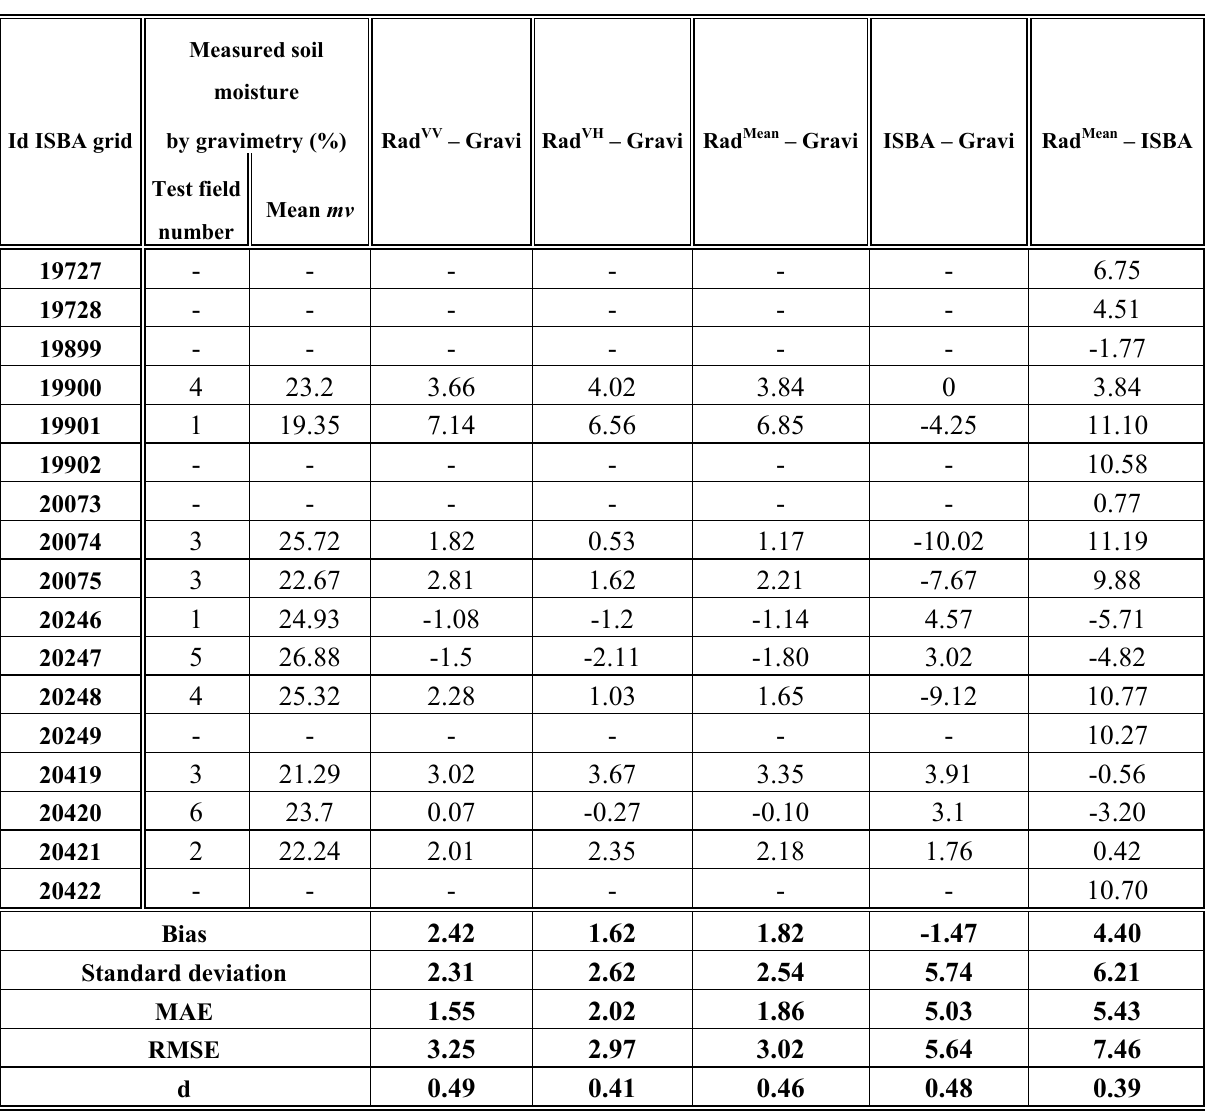
Table 2. Comparison between soil moistures measured by gravimetry, simulated by ISBA model, and estimated from ASAR images of March 12, 2007 (scale of ISBA grids).”Rad Mean ” corresponds to radar soil moisture obtained by the mean estimate of VV and VH